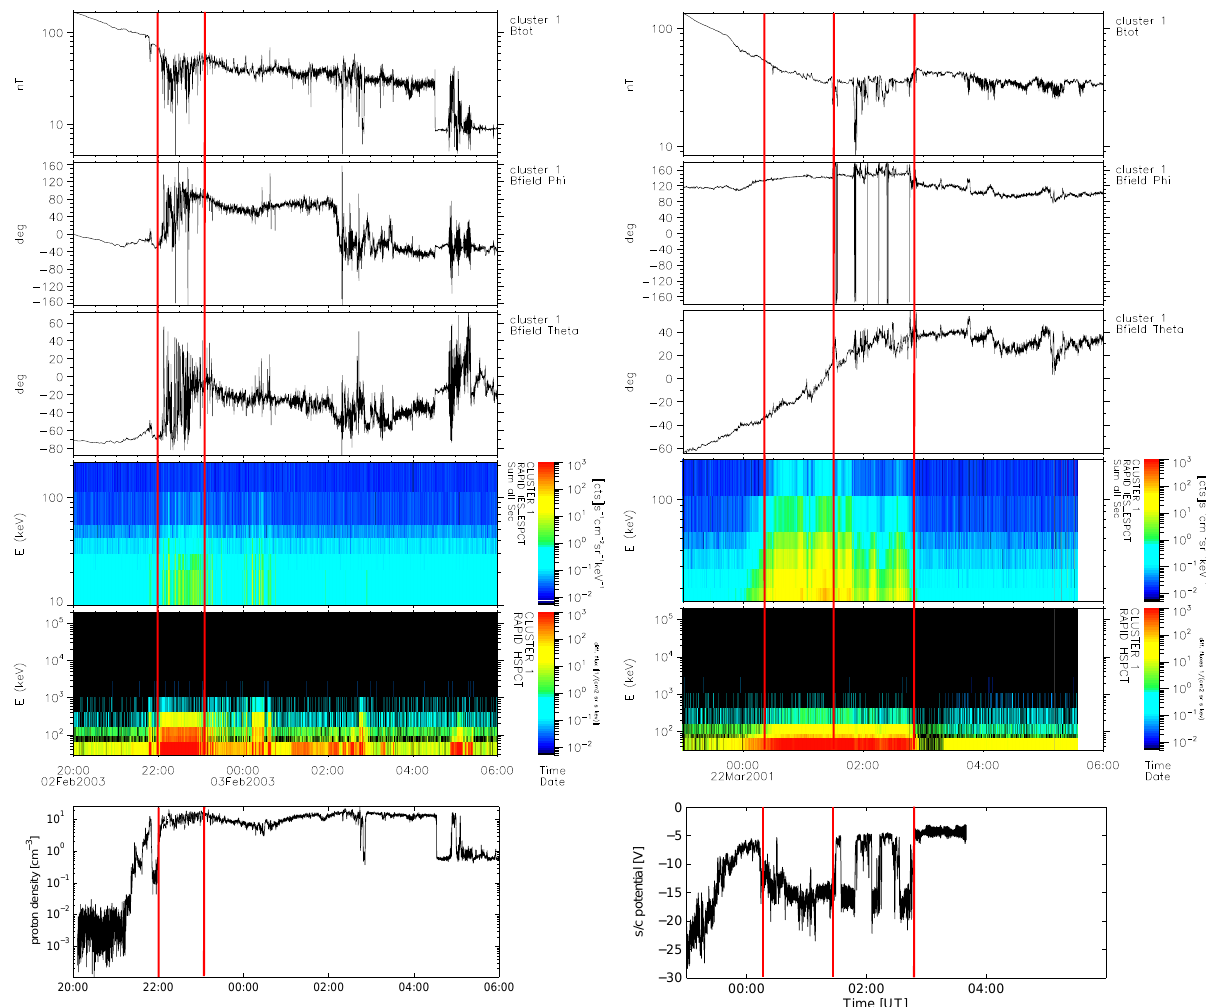
Fig. 1. Sample of Cluster FGM and RAPID data. From top to bottom: total magnetic field intensity, azimuthal angle ( φ ) and polar angle ( θ ) of magnetic field, electron and proton energy spectra, and plasma density (left side figure) and spacecraft potential (right side figure). Left side: 2 February 2003, right side: 22 March